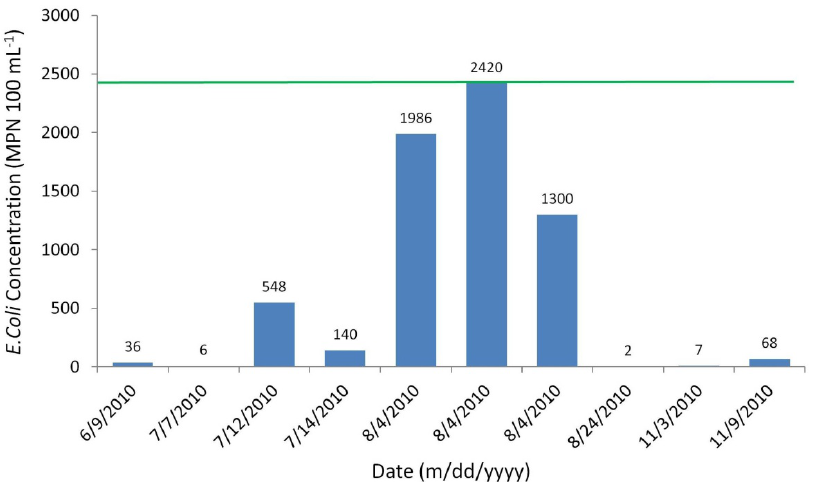
Figure 8. Observed E. coli concentrations of Moose River water samples.